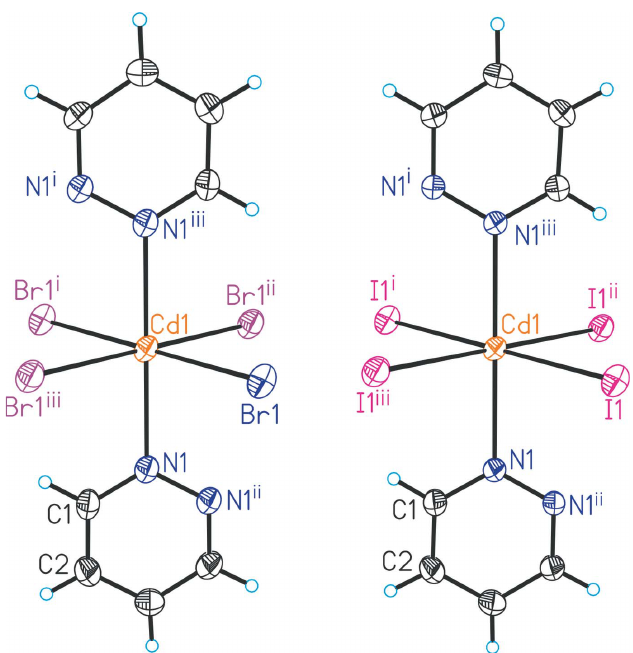
Figure 1 The metal atom polyhedra in 1 (left) and 2 (right) with labeling and displacement ellipsoids drawn at the 50% probability level. Symmetry codes for the generation of equivalent atoms: (i) (cid:5) x + 1 , (cid:5) y + 1 , (cid:5) z + 1 ; (ii) 2 2 2 (cid:5) x + 1, (cid:5) y + 1 , z ; (iii) x (cid:5) 1 , y , (cid:5) z + 1 . 2 2 2